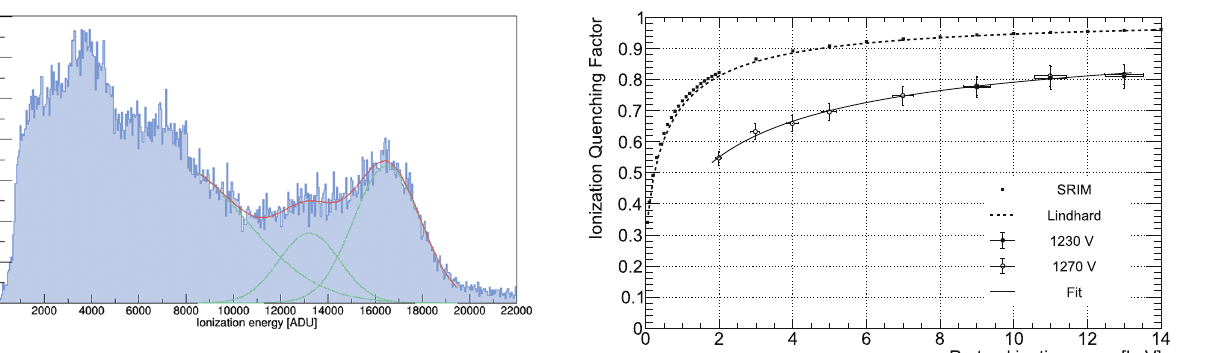
Fig. 8 Example of a 9 keV proton spectrum at 1230 V showing the difficult separation between H + and H + . The H + peak can be identified 2 2 Fig. 9 Ionization Quenching Factor for protons in 100 mbar of around 13 , 000 ADU whereas the H + peak is around 17 , 000 ADU. The methane. The measurements at 1230 V and 1270 V are respectively presence of H + is related to the low amount of He introduced in the 2 presented with black dots and white dots. Comparisons with SRIM and Comimac source during this campaign with the Lindhard theory are also